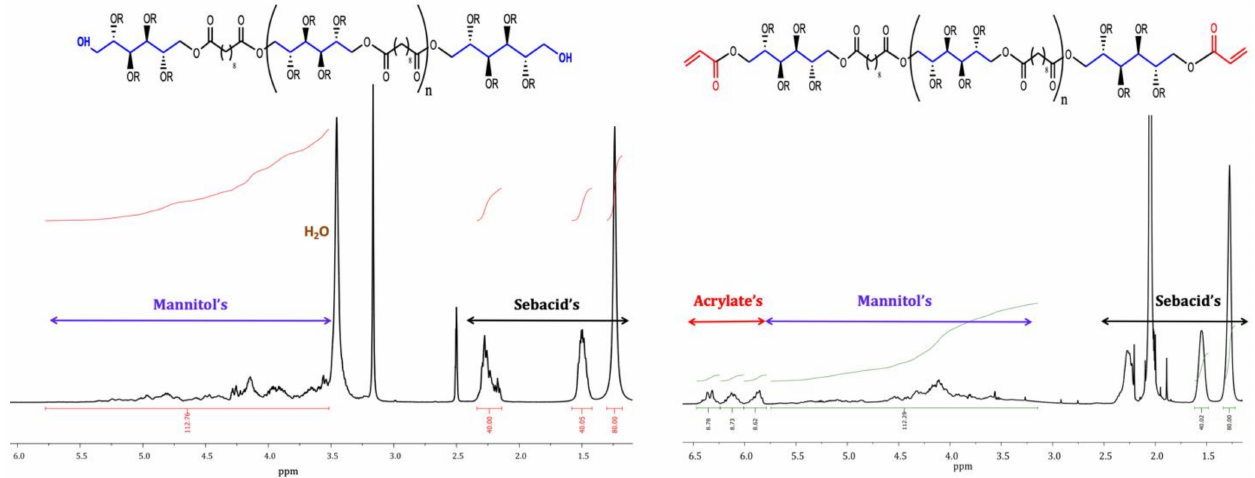
Figure 1. 1 H-NMR spectra of the synthesized PMS and